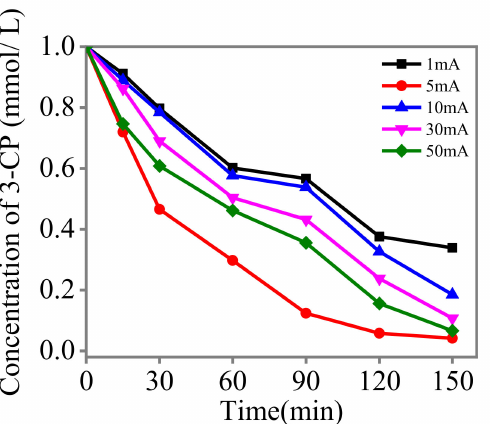
Figure 8. Effect of the currents for the variation of the 3-CP